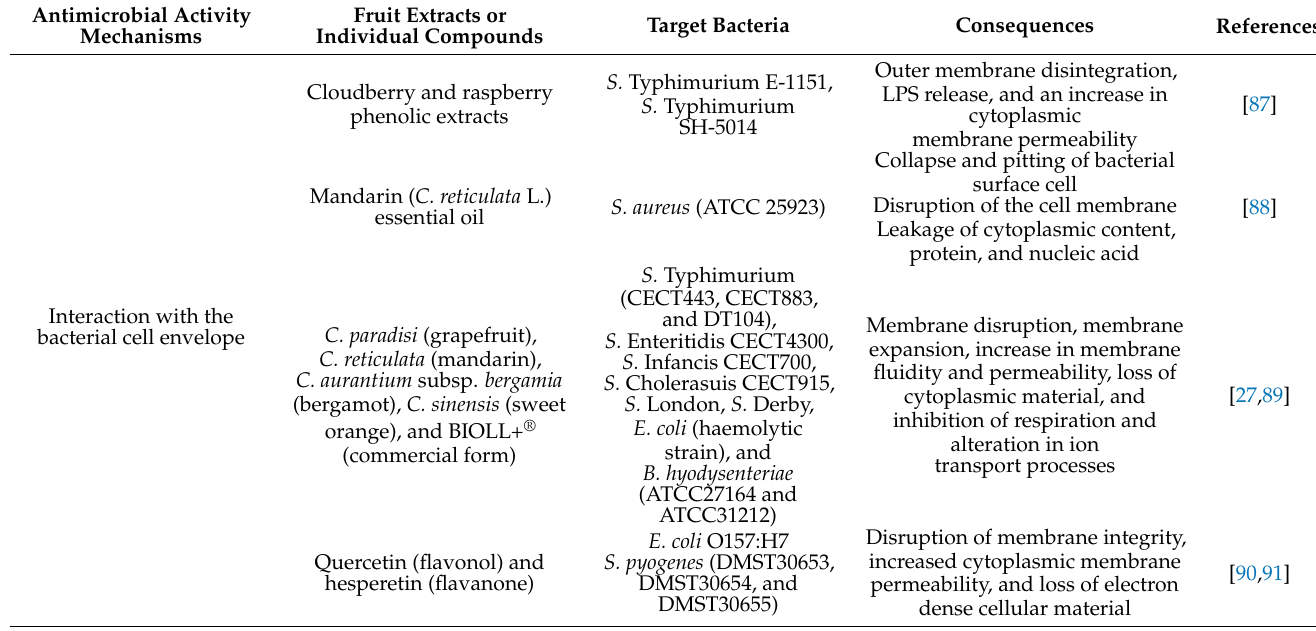
Table 3. Mechanisms of action of fruit extracts as antimicrobial